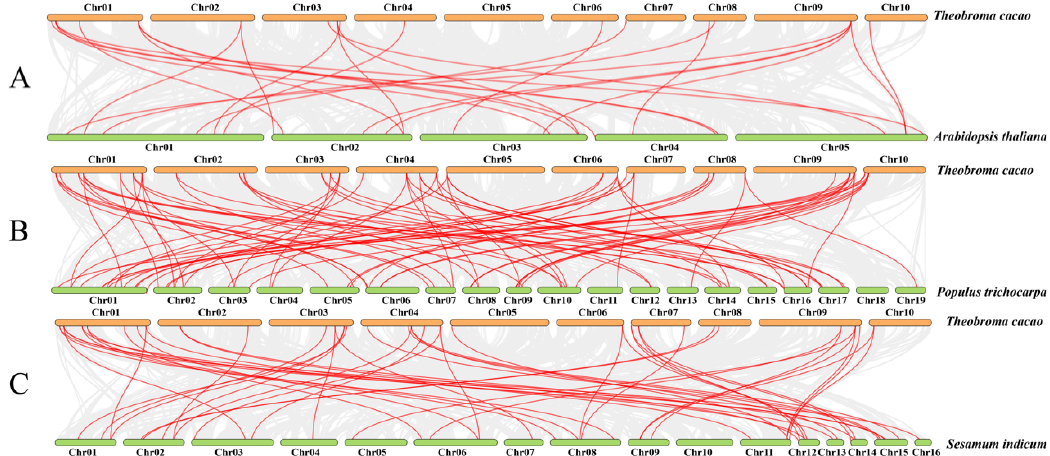
Figure 5. Visualization of the syntenic analysis. Synteny of the GRAS genes in T. cacao with the GRAS genes of A. thaliana ( A ), T. cacao ( B ), and S. indicum ( C ) was visualized by MCScanX analysis of TBtools software. Gray lines between the genomes show all synteny blocks, and red lines between the genomes indicate the synteny between the genes.